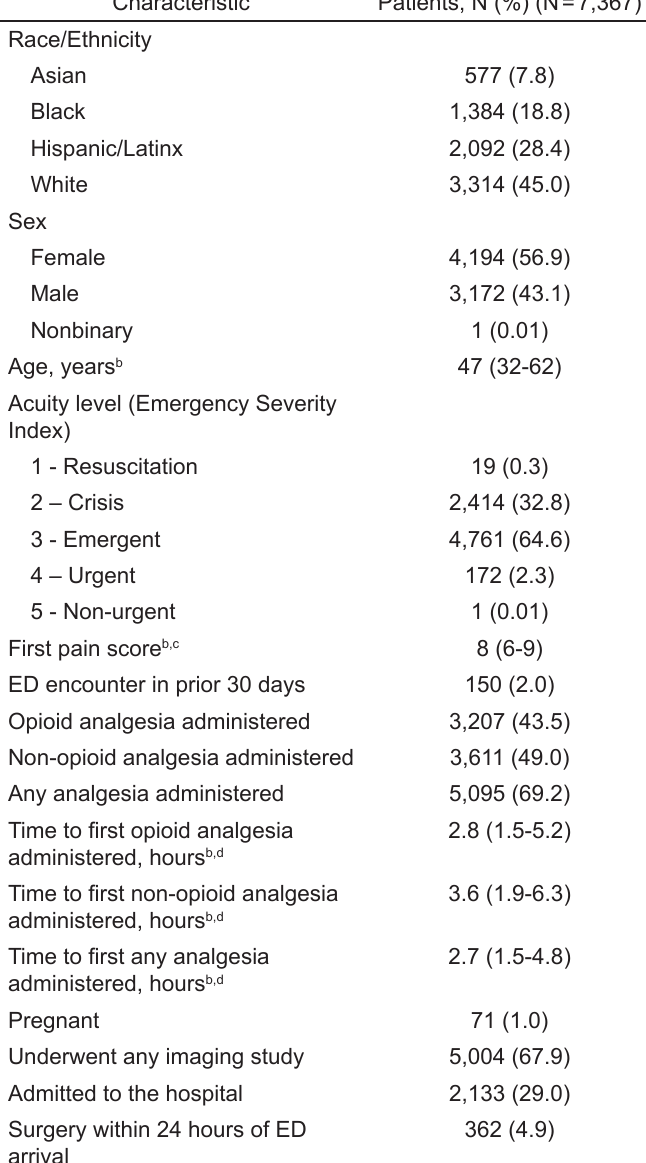
Table 1. Patient characteristics: emergency department index encounter.